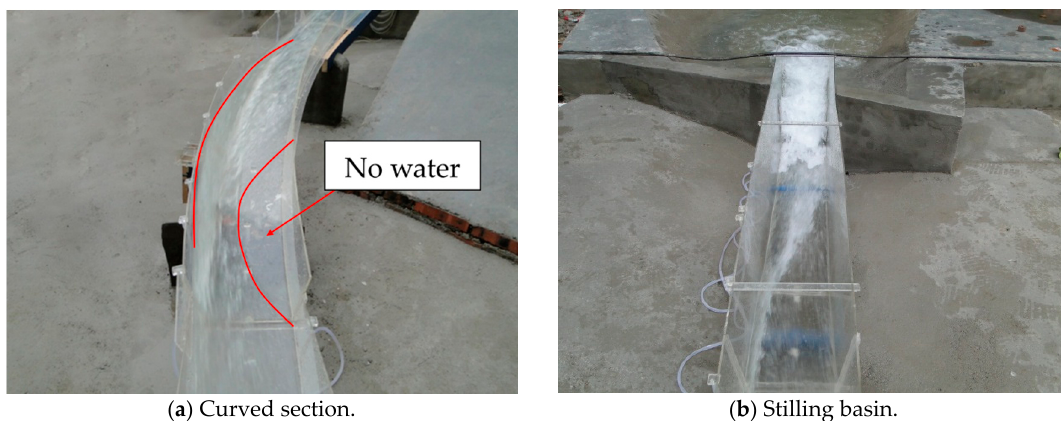
Figure 5. Flow regime in the curved section and stilling basin of the smooth spillway.